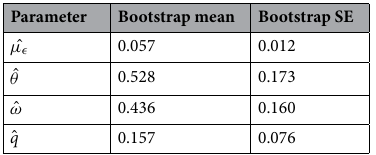
Table 3. Bootstrap means and standard errors of the proposed model for the Heilongjiang Covid-19 example.